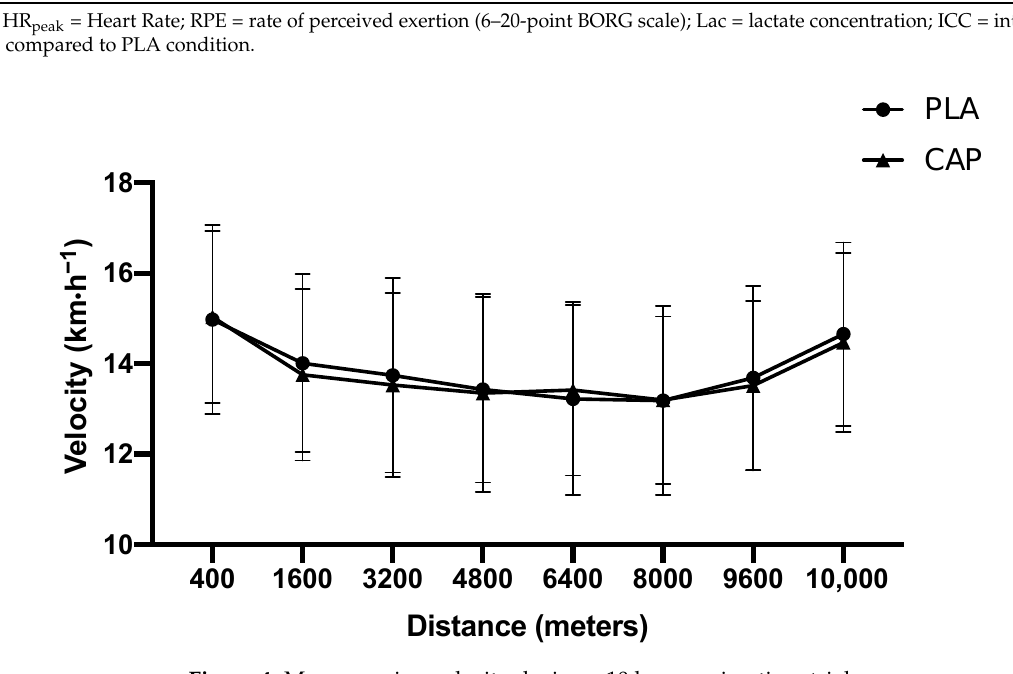
Figure 4. Mean running velocity during a 10 km running time-trial.